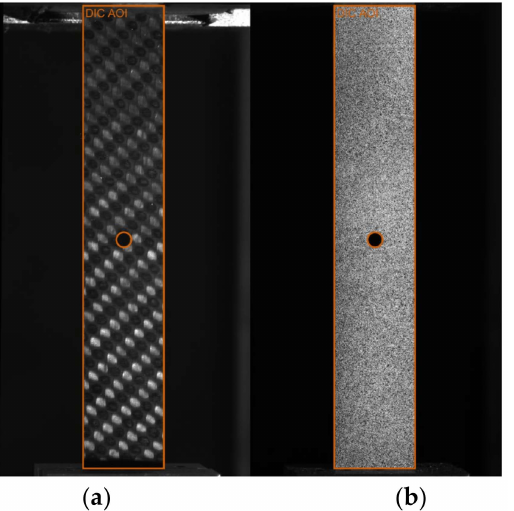
Figure 1. Images of one of the notched specimens (C22) on the test fixture, captured with one of the cameras used for DIC: ( a ) reference image used to build the model; ( b ) speckle image taken during testing. The DIC area-of-interest is overlayed on both